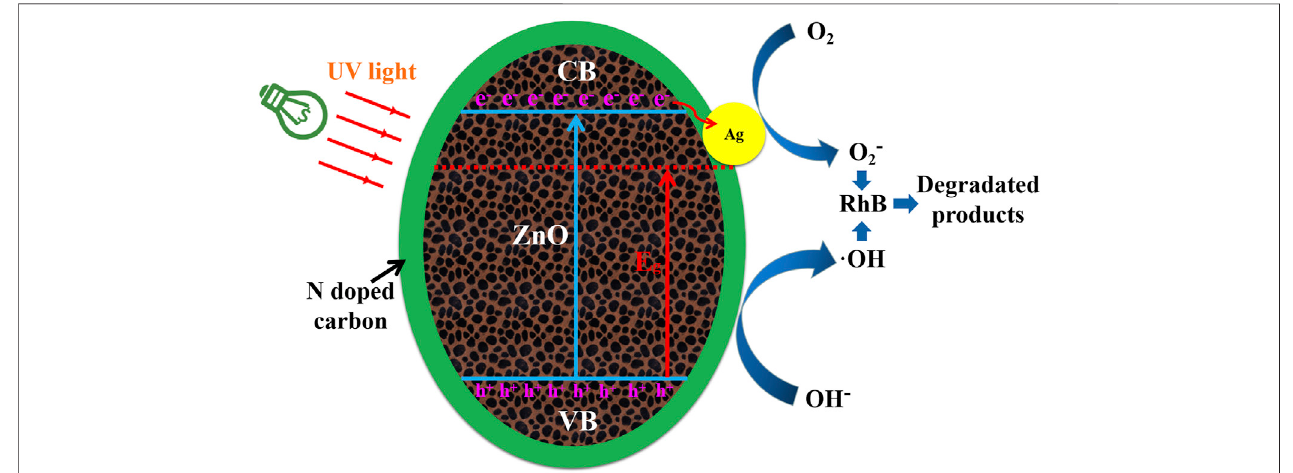
FIGURE 10 | The possible schematic diagram of Ag/ZnO@N-carbon for degradation of RhB under UV light.